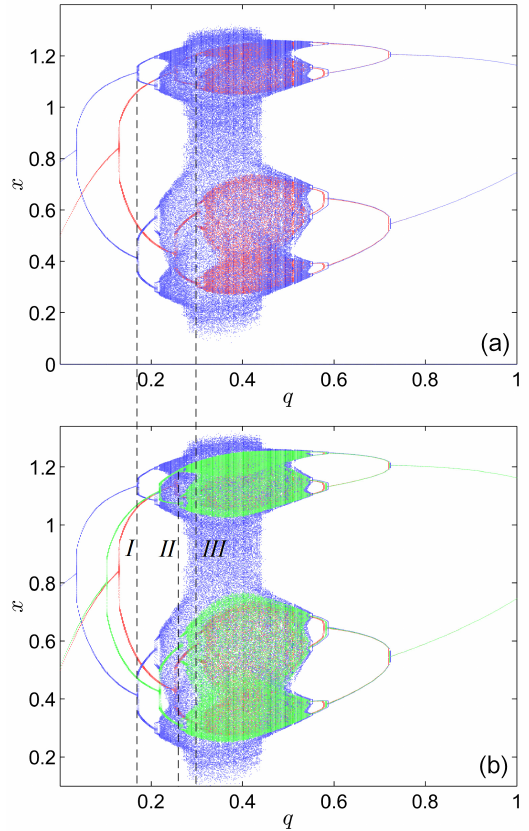
Figure 5. The BDs of system (8) for p = 0.55. ( a ) Initial conditions ( 0.1,0.3 ) (red BS) and ( 0.5,0.5 ) (blue BS); ( b ) Initial conditions ( 0.1,0.3 ) (red BS), ( 0.5,0.5 ) (blue BS) and ( 0.01,0.7 ) (green